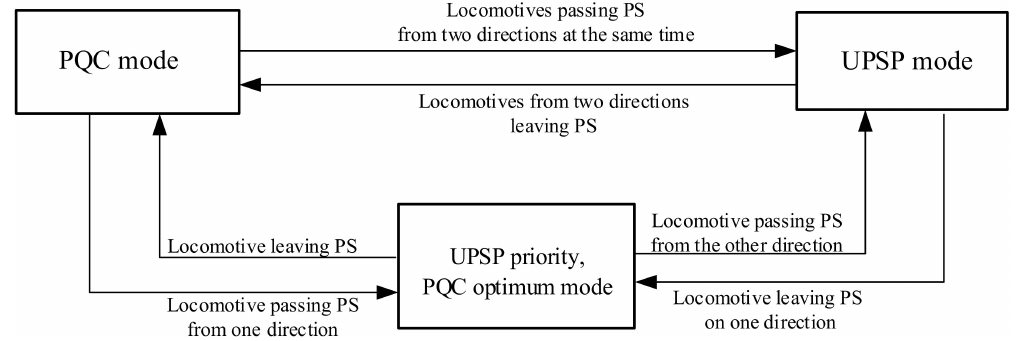
Figure 3. Working modes transition diagram of UPSP-PQC